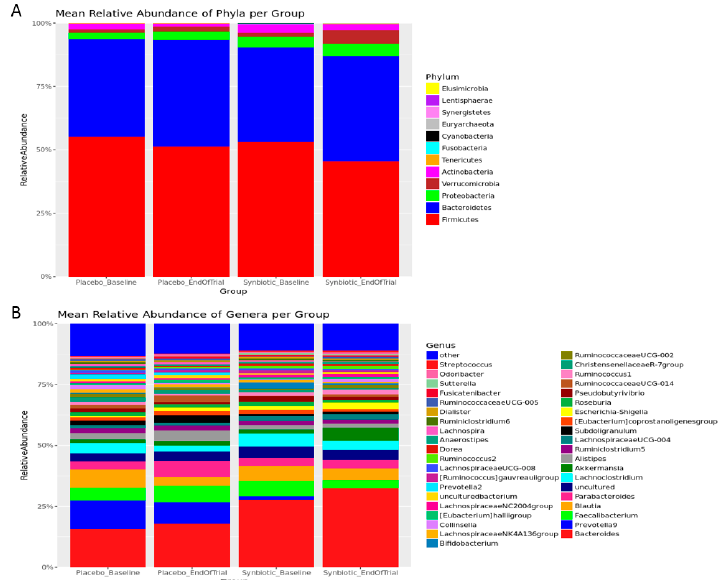
Figure 1. Mean relative abundance (%) of phyla ( A ) and genera ( B ) by the treatment groups and time points.